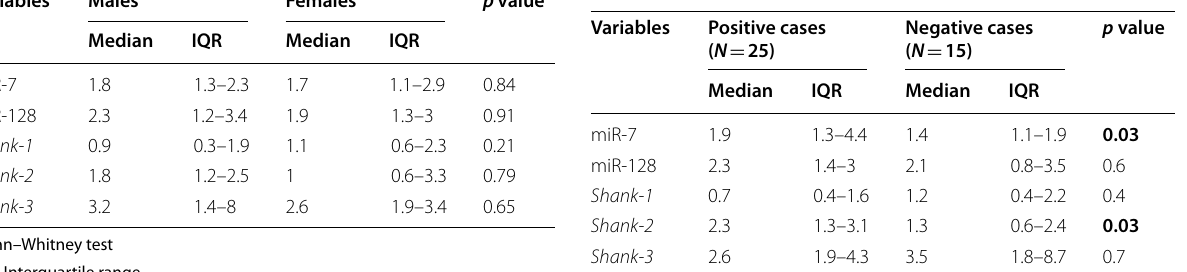
Table 4 Comparison between the expression of miRNA‑7, miRNA‑128 and SHANK family genes regarding gender